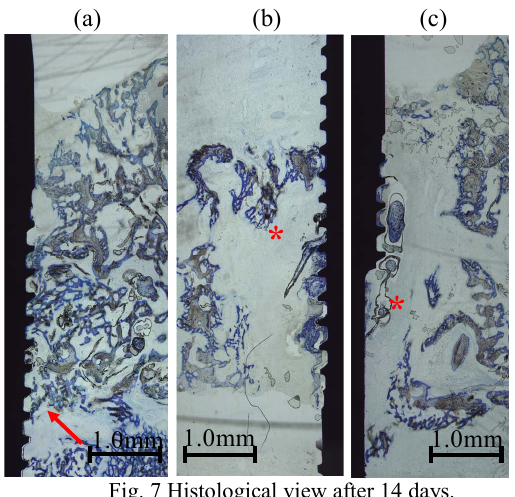
Fig. 7 Histological view after 14 days.